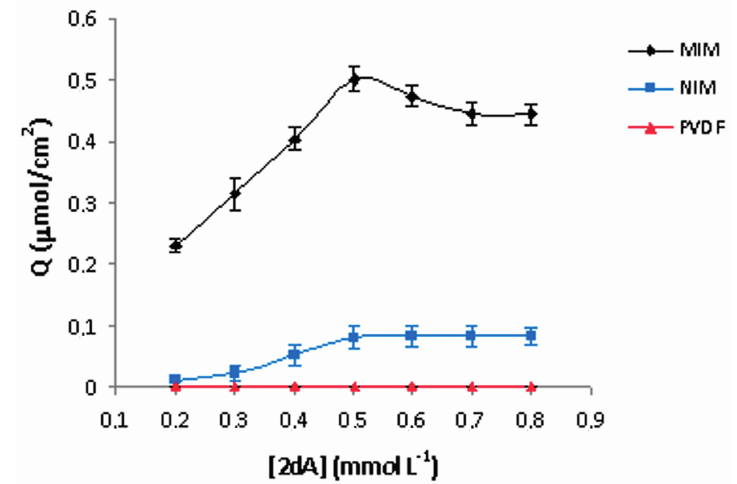
Figure 5. Batch rebinding experiments of MIMs, NIMs and PVDF membranes.